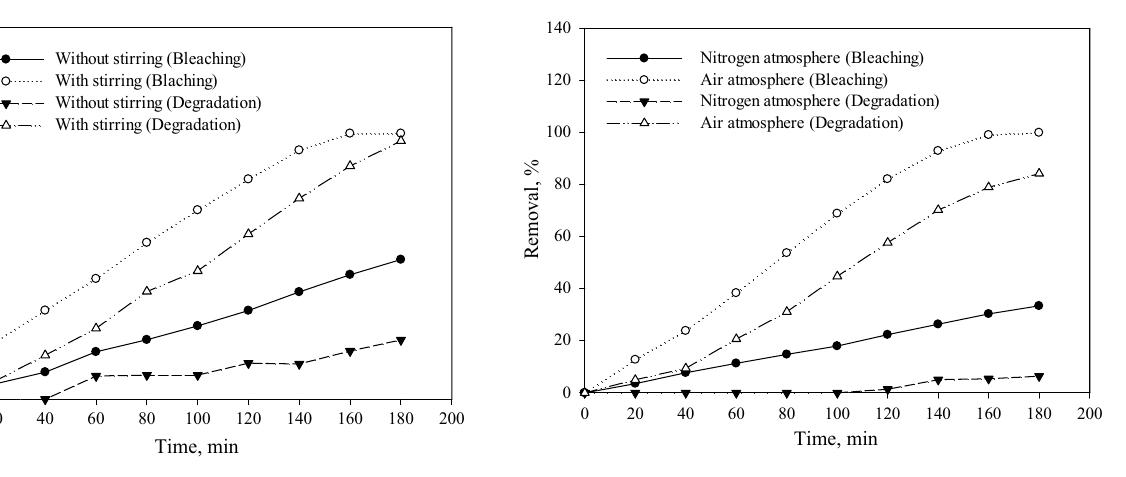
Fig. 10 Effect of stirring the solution on the rate bleaching and dye Fig. 11 Effect of oxygen on the rate bleaching and dye degradation of